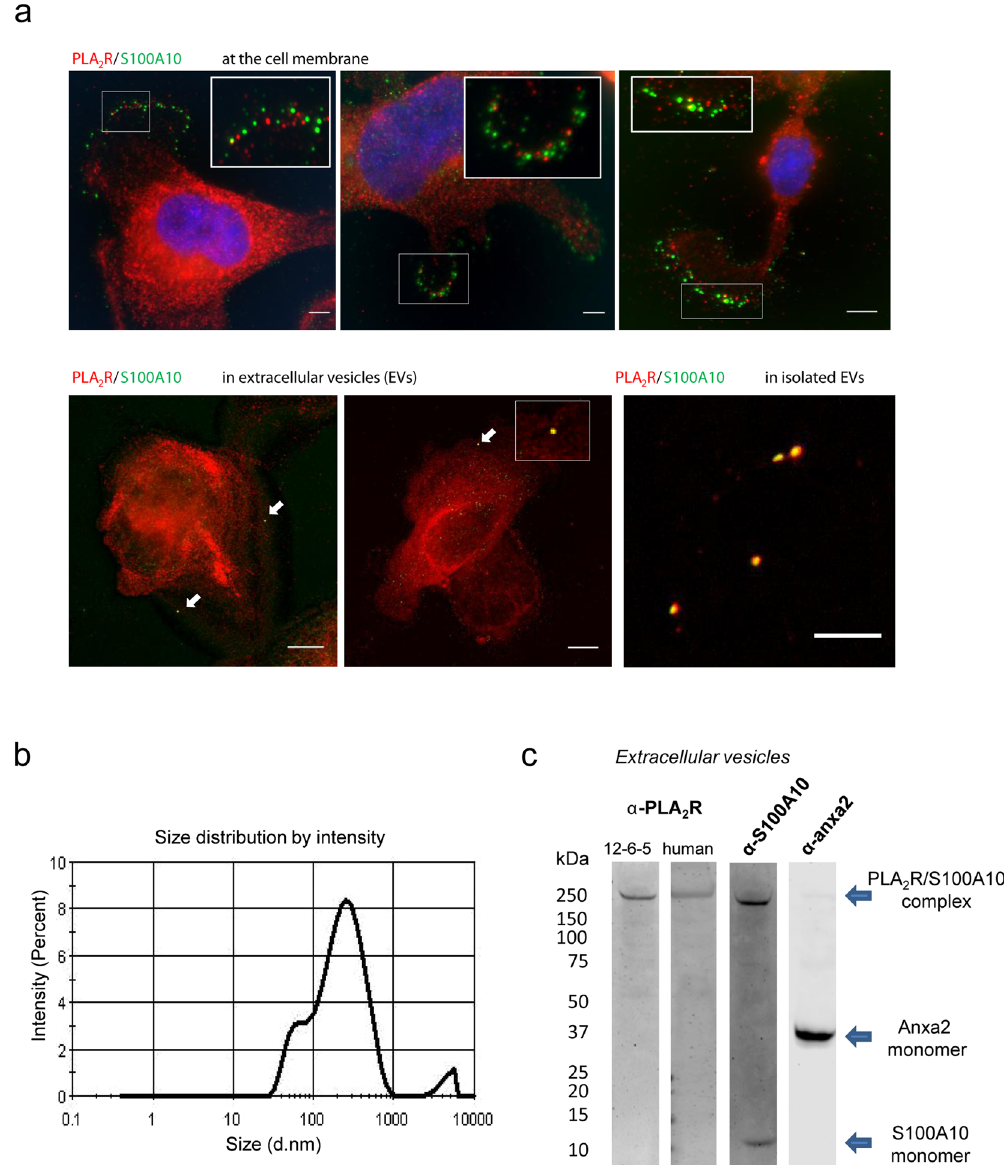
Figure 4. PLA 2 R is found in vesicles secreted by podocytes. ( a ) Co-localisation of PLA 2 R/S100A10 at the cell surface and in vesicles. Podocytes cultured on coverslips were fixed and co-stained using antibodies against S100A10 (green) and PLA 2 R (red) mAb 12-6-5. Merged images demonstrate some regions of overlap (yellow) between the PLA 2 R and S100A10 at the cell membrane ( top panel ) and in vesicles ( left bottom panels ). Scale bars, 10 μ m. Purified extracellular vesicles (EVs) secreted from podocytes were incubated on poly-D-lysine coated glass slide and co-stained for PLA 2 R and S100A10 showing positive staining for both proteins. ( b ) Representative size distribution by intensity profile of extracellular vesicles (EVs) measured by Dynamic Light Scattering (DLS). EVs intensity distributions reveal two characteristic peaks occurring at ~60 nm and ~200 nm. These two values are in agreement with the average values reported in literature for exosomes and microvesicles, respectively. ( c ) Vesicles characterisation. Isolated EVs from serum-free conditioned cell culture media of differentiated podocytes were analysed by western blotting using anti-PLA 2 R, anti-S100A10 and anti-Anxa2 antibodies. A ~250 kDa band was detected by both anti-PLA 2 R and anti-S100A10 antibodies corresponding to the tightly associated PLA 2 R/S100A10 complex. Anxa2 was also detected in the EVs fraction as a monomer around ~37 kDa suggesting it has dissociated from the complex under denatured